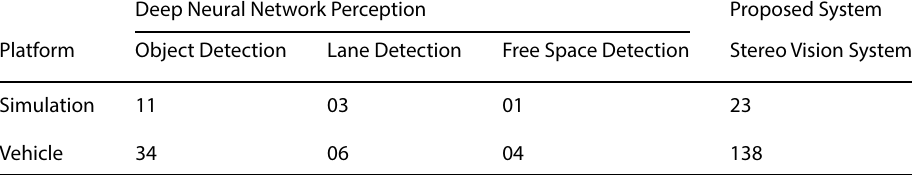
Table 1 Processing time (in